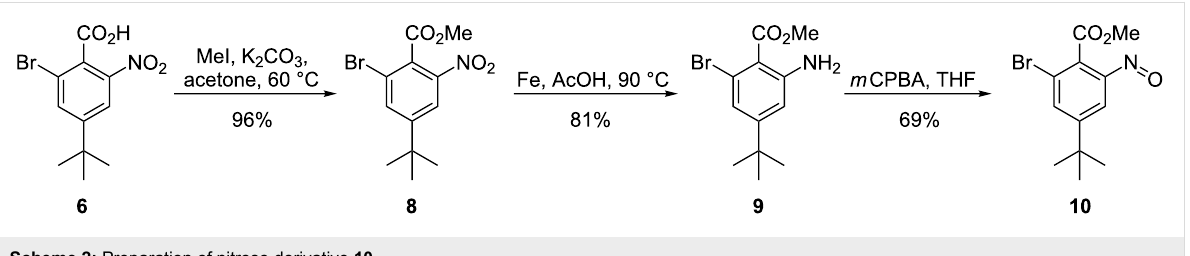
Scheme 2: Preparation of nitroso derivative 10